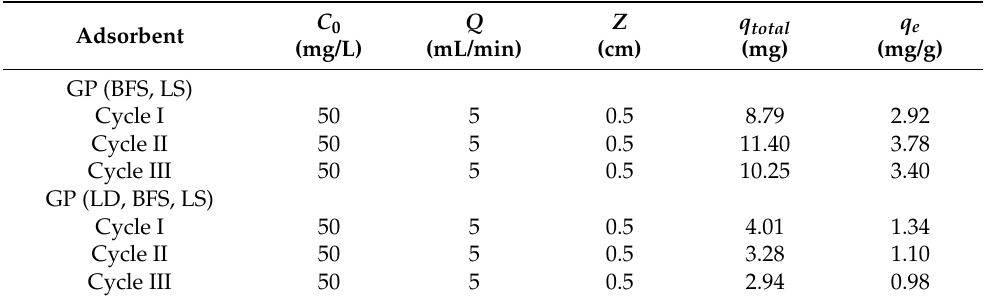
Table 2. Parameters of the total uptake of nickel(II) ( q total ), equilibrium nickel(II) uptake ( q e ), and total percentage of nickel(II) removal at a fixed-bed height and concentration during three cycles. The bed height ( Z ) remained almost constant during the three cycles.